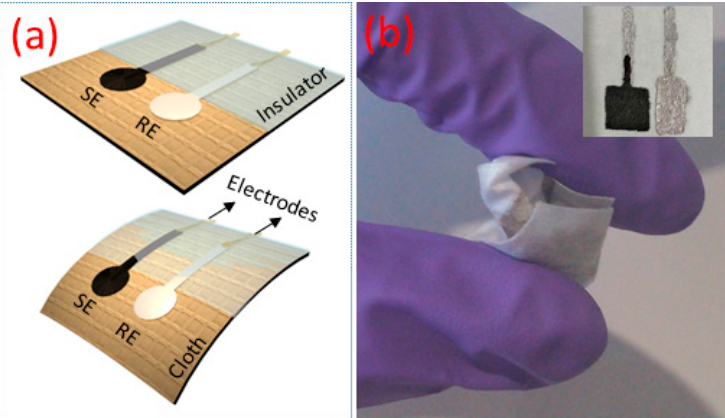
Figure 1. ( a ) Schematic representation of flexible potentiometric pH sensor (SE-sensitive electrode and RE-reference electrode) on cloth. ( b ) The image of flexible and crumpled pH sensor (inset shows image of the electrodes).